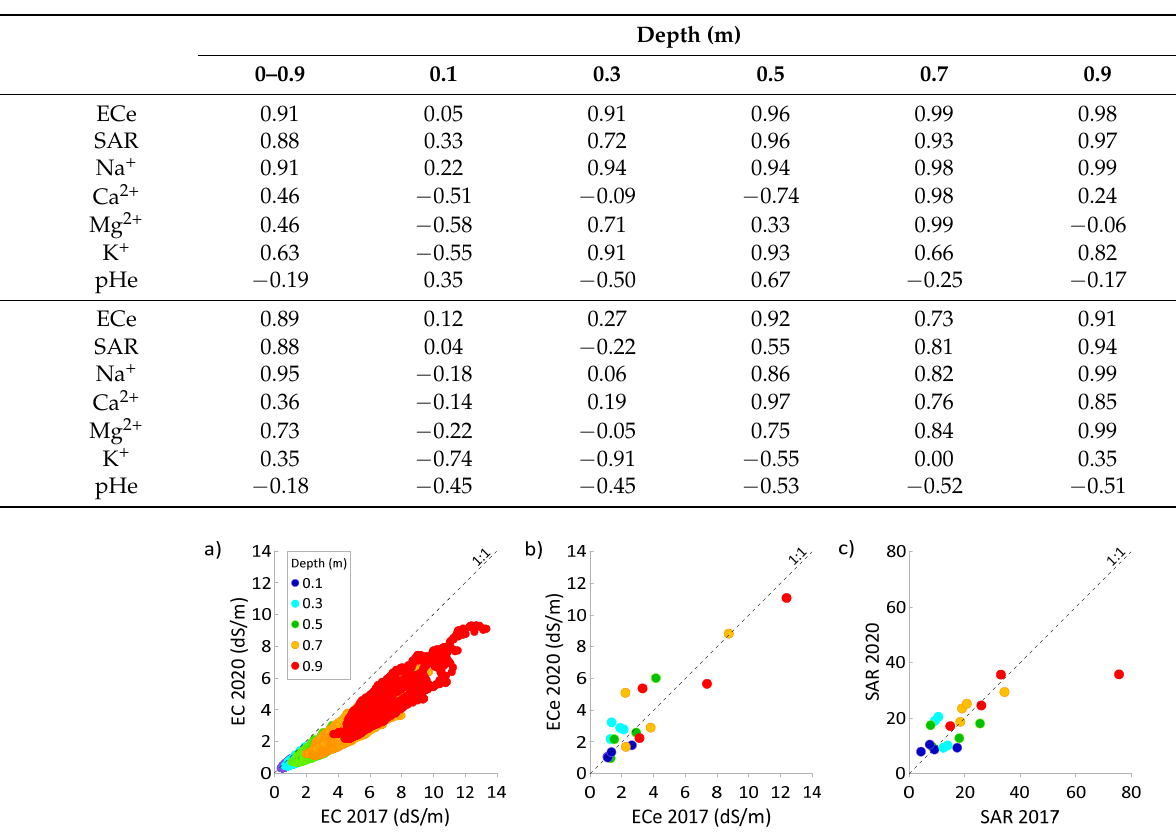
Table 3. Pearson correlation coefficient (R) between depth-specific EC and soil chemical properties measured in 2017 and 2020, and correlations by depths.